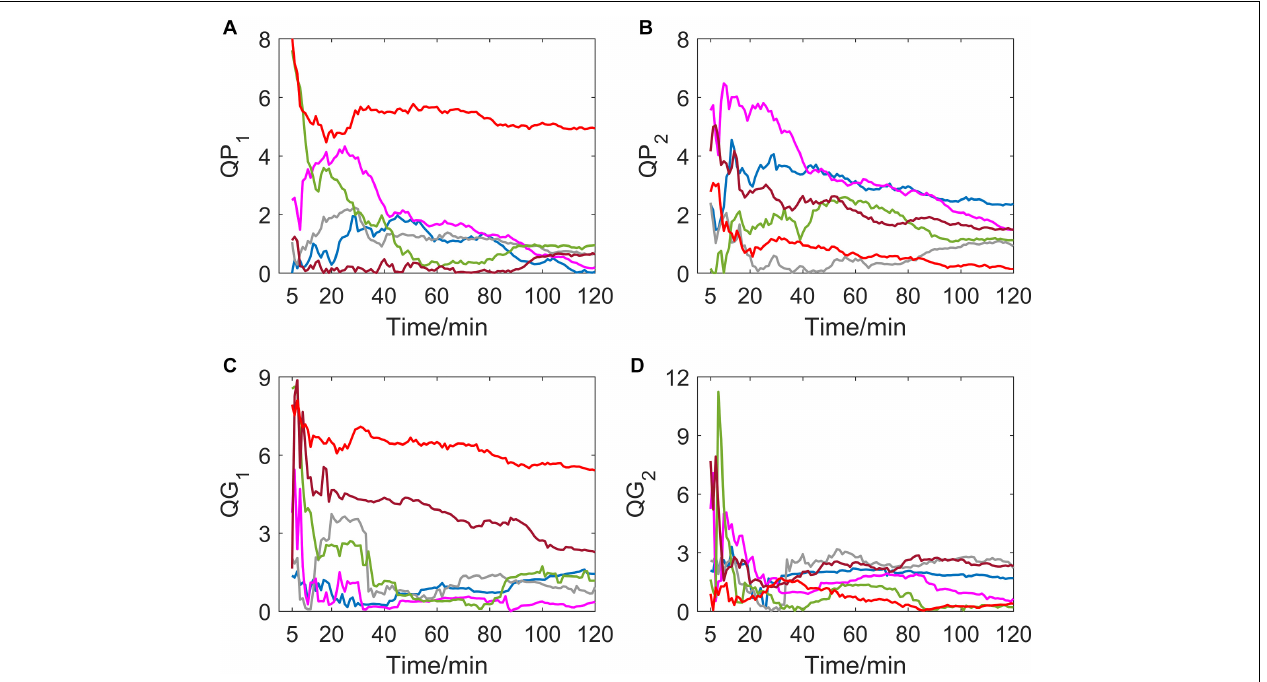
FIGURE 1 | (A–D) show the corresponding results of QP 1 , QP 2 , QG 1 , and QG 2 . Variation tendency of QP 1 , QP 2 , QG 1 , and QG 2 within 2 h of hypoxic group (each color represents a subject, the same below).